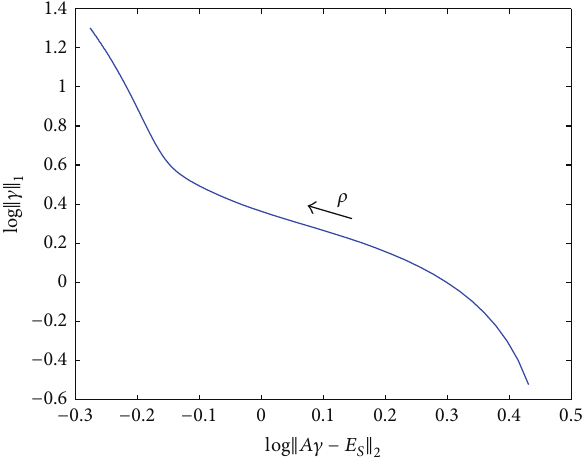
Figure 8: L-curve using LASSO